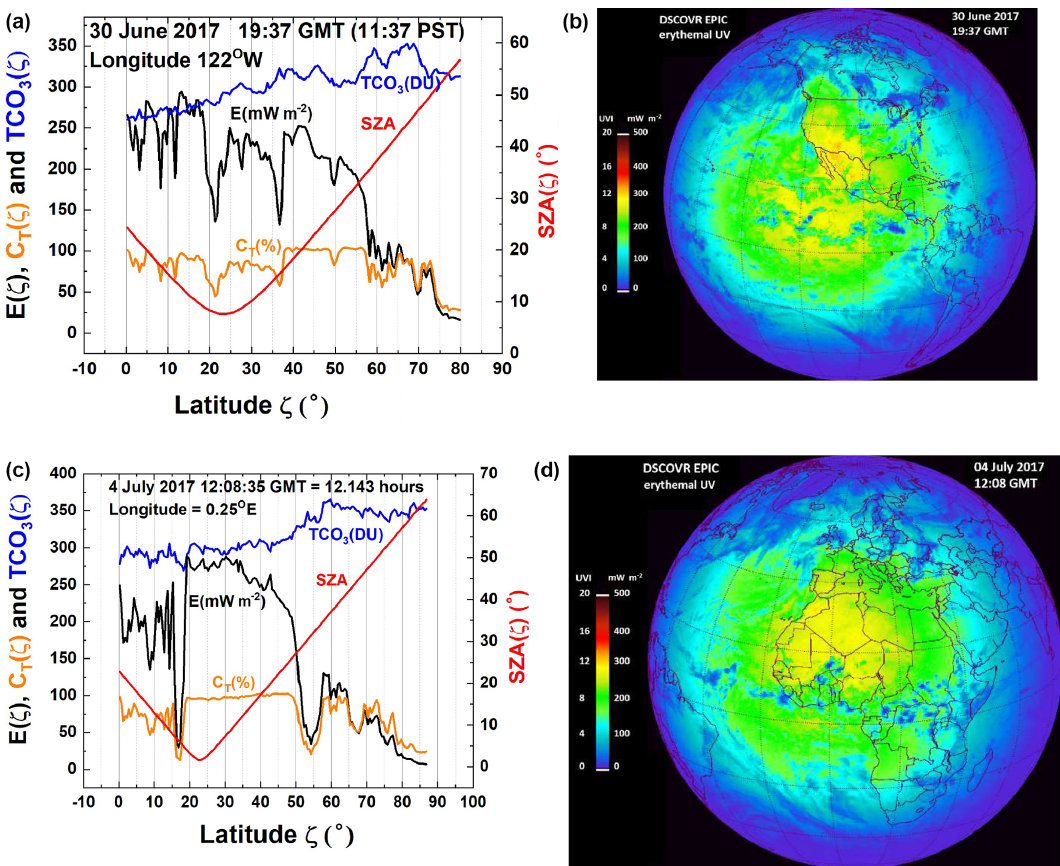
Figure 11. (a) Latitudinal distribution of E(ζ) and its contributing factors TCO 3 , C T , and SZA for a line of longitude passing through San Francisco, CA. (b) Global distribution of E(ζ,ϕ) from DSCOVR EPIC data on 30 June 2017 19:17GMT when there were few clouds. Figure map created with IDL ® . (c) Latitudinal distribution of E(ζ,ϕ,z,t) and its contributing factors TCO 3 , C T , and SZA for a line of longitude passing near Greenwich, England. (d) Global distribution of E(ζ,ϕ,t O ) from DSCOVR EPIC data on 4 July 2017 12:08GMT. Figure map created with IDL ®